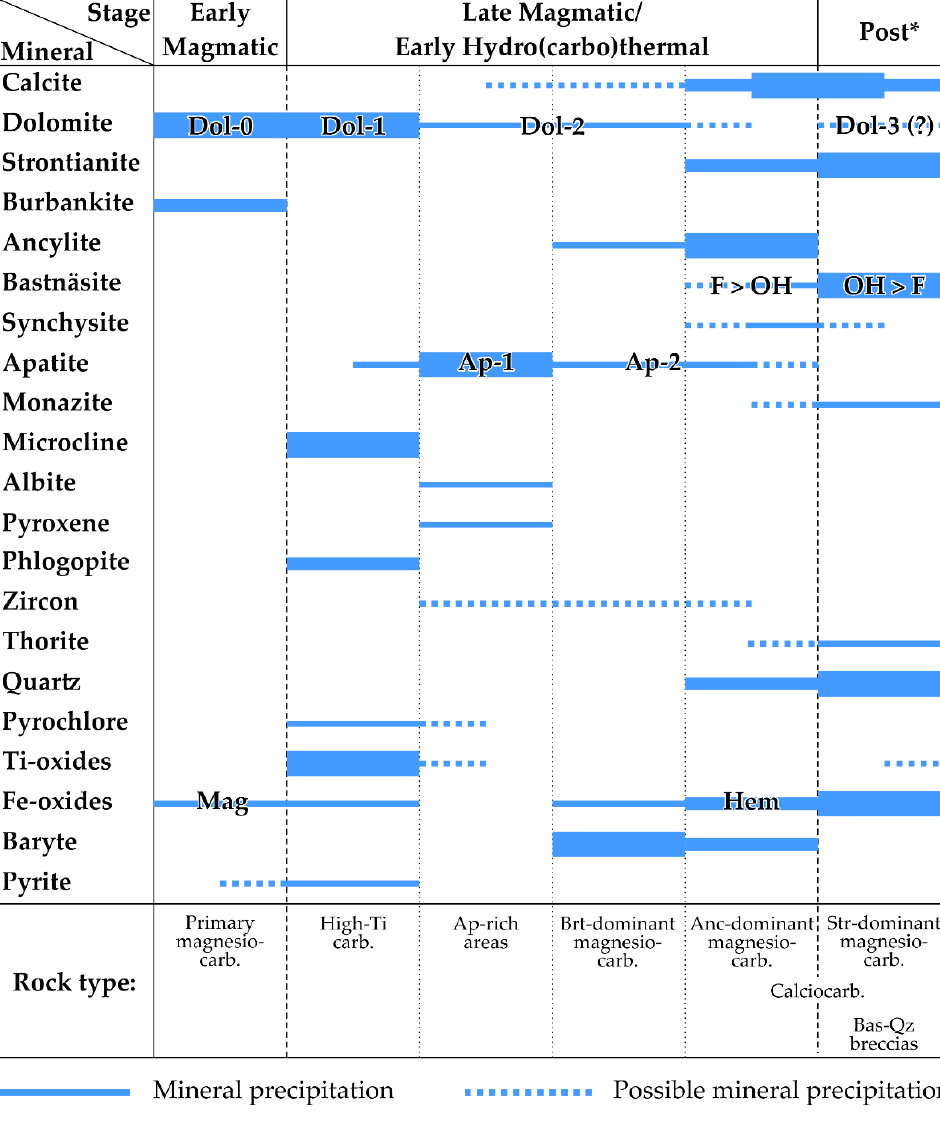
Figure 2. The proposed paragenetic sequence of minerals in Petyayan-Vara carbonatites [16]. Note: Post* includes both the late hydro(carbo)thermal and the supergene stages. Line thickness indicates deposition intensity.